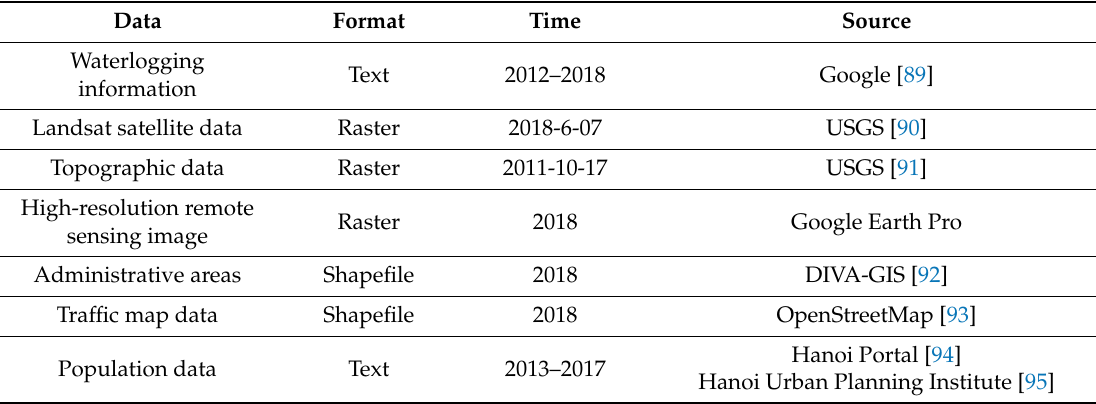
Table 1. List of data